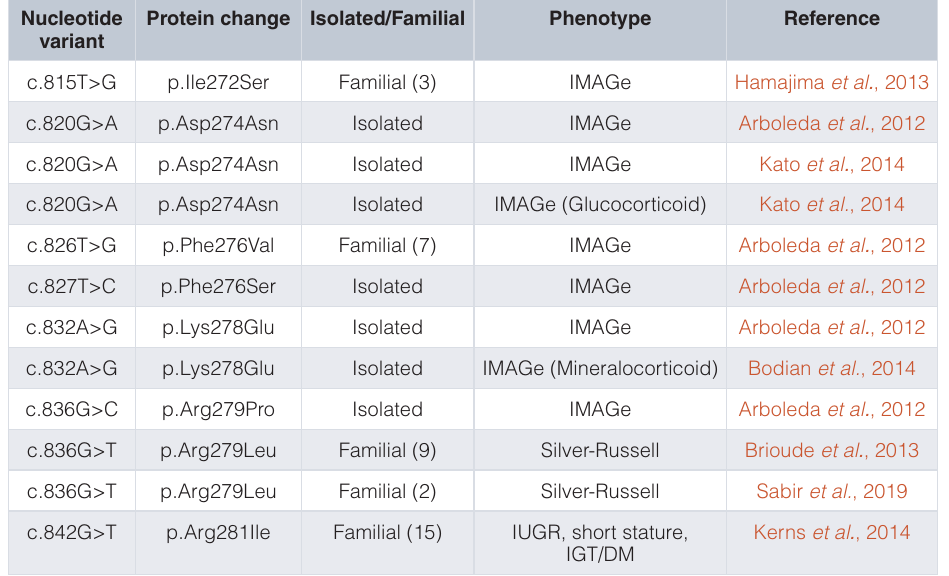
Table 2. Reported variants in CDKN1C and associated phenotypes.